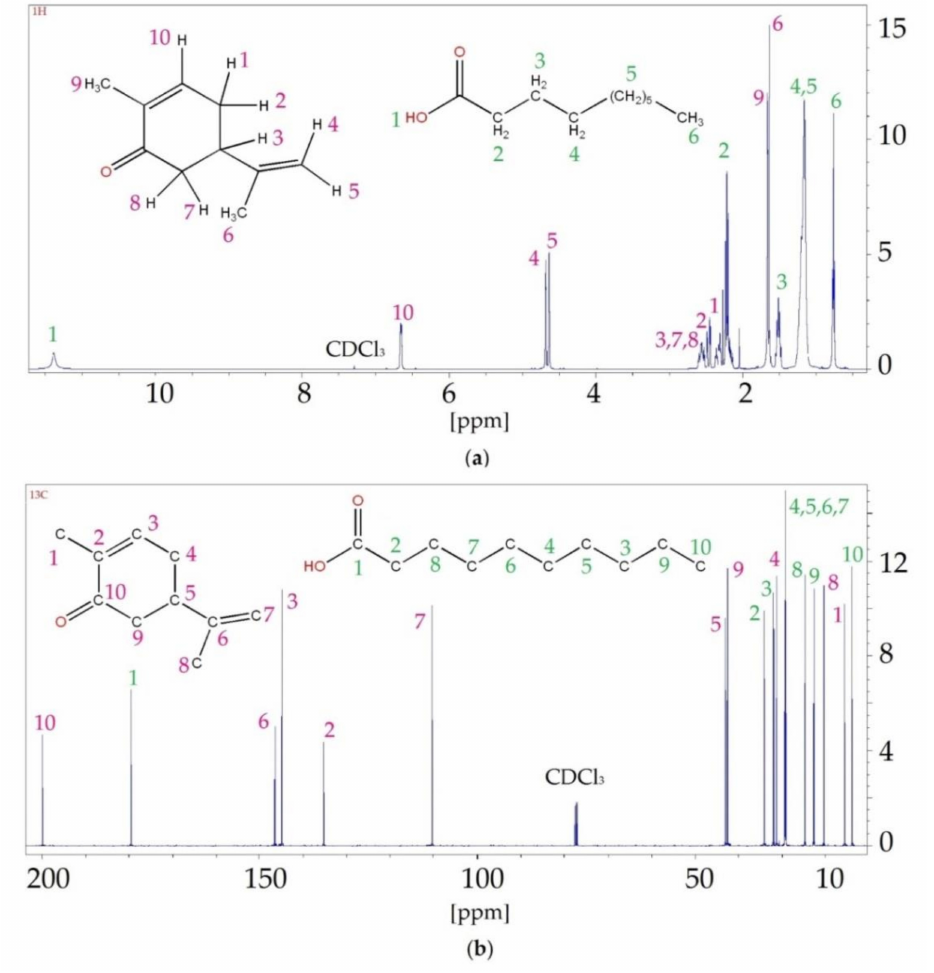
Figure 7. 1 H NMR ( a ) and 13 C NMR ( b ) spectrum of the C:DA